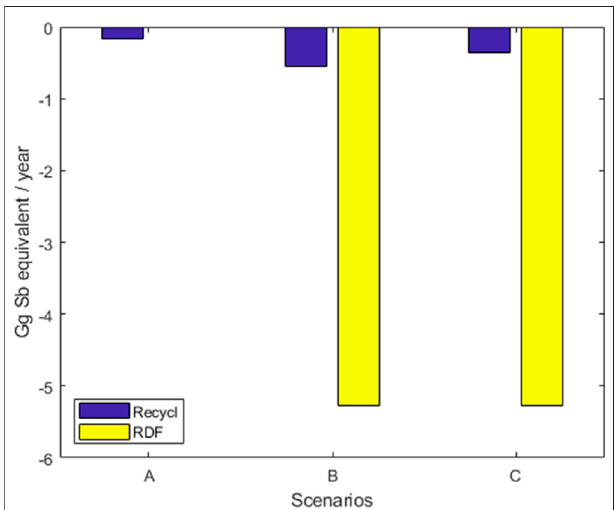
FIGURE 5 | Abiotic resource depletion savings per scenario. Savings due to recycling of recoverable materials (Recycl), Savings due to RDF co- processing in cement kiln